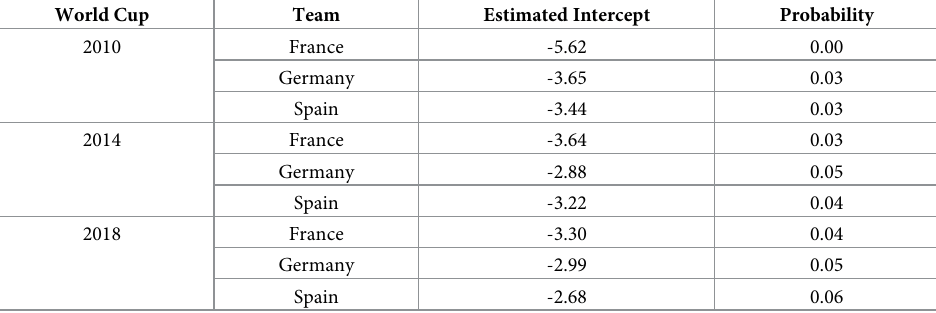
Table 4. Estimated log odds, standard errors, confidence intervals and p-values for a possession resulting in a return to the defensive zone.